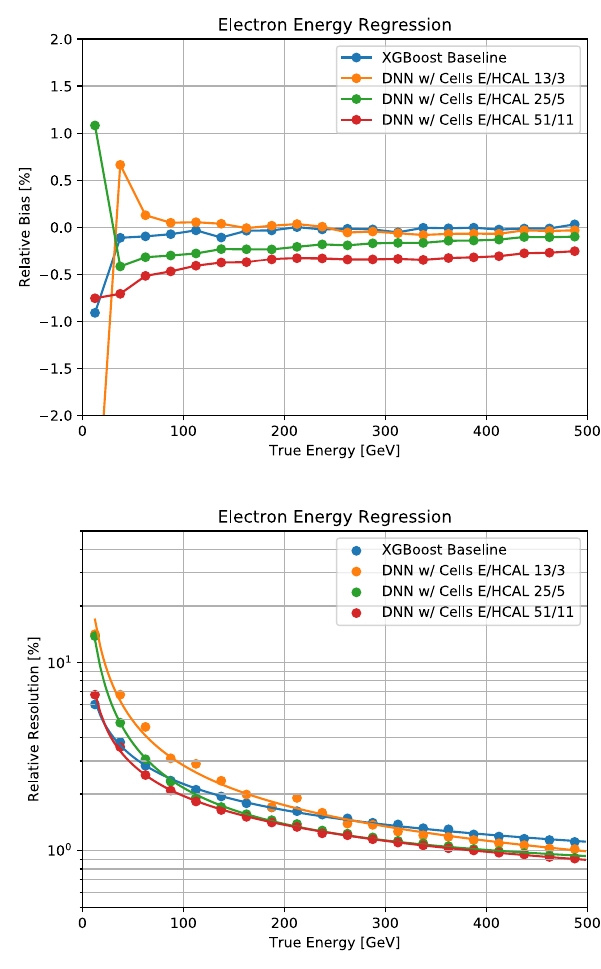
Fig. 40 Bias (top) and resolution (bottom) as a function of true energy for DNN energy predictions for electrons, with varying input window sizes